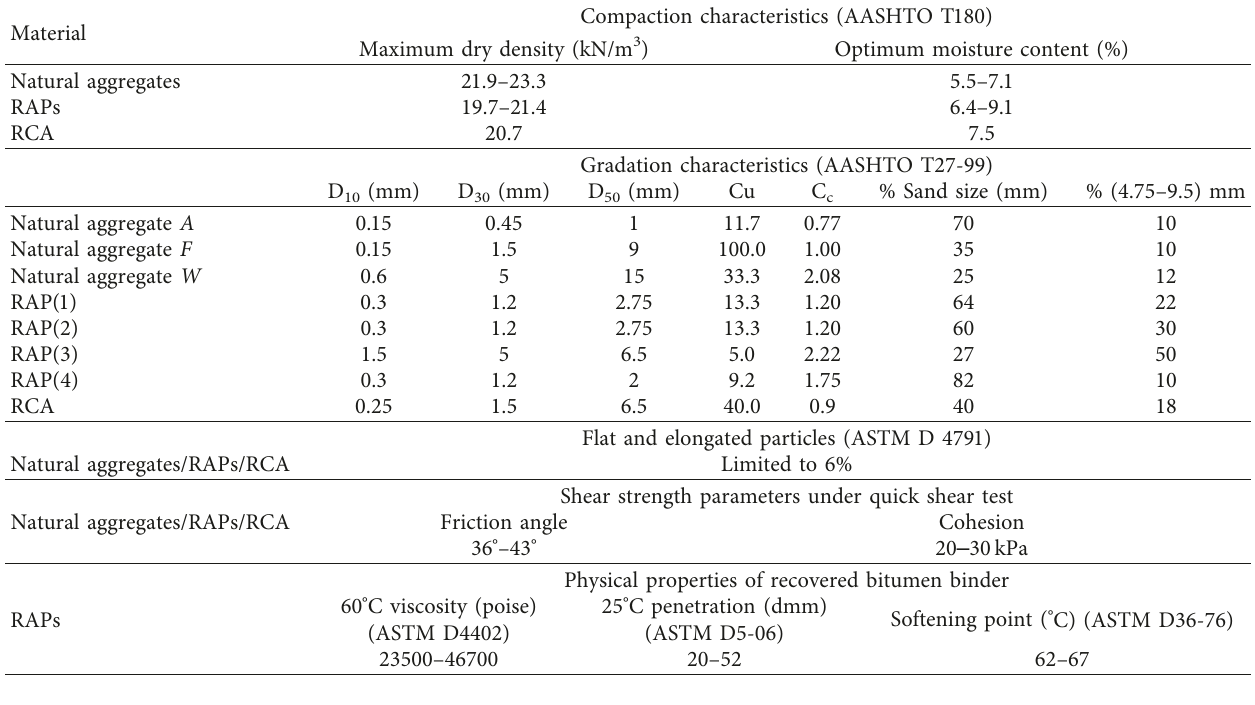
Table 2: Characterisation of the tested materials.